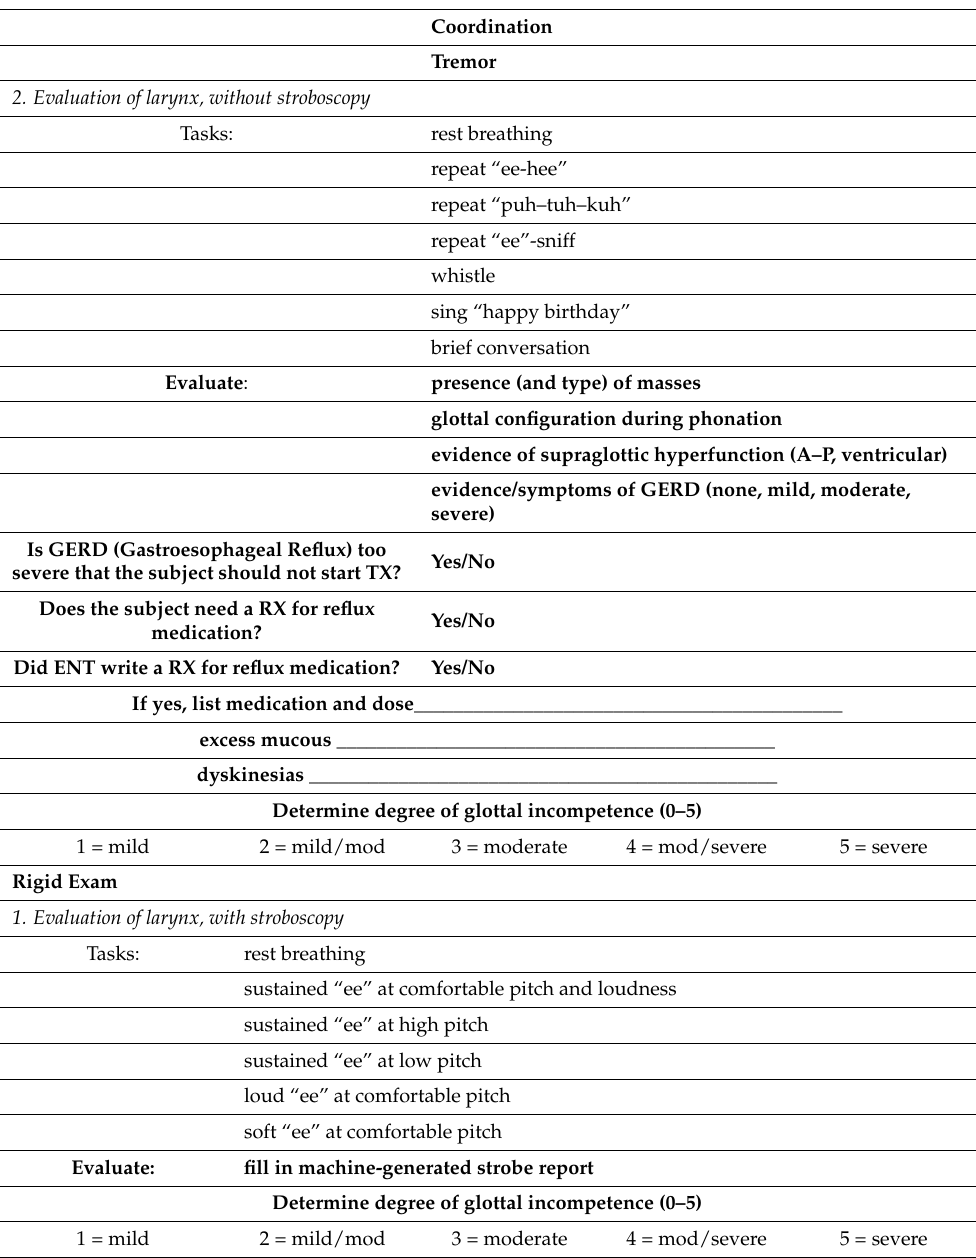
Table A5. Assessment of velopharyngeal